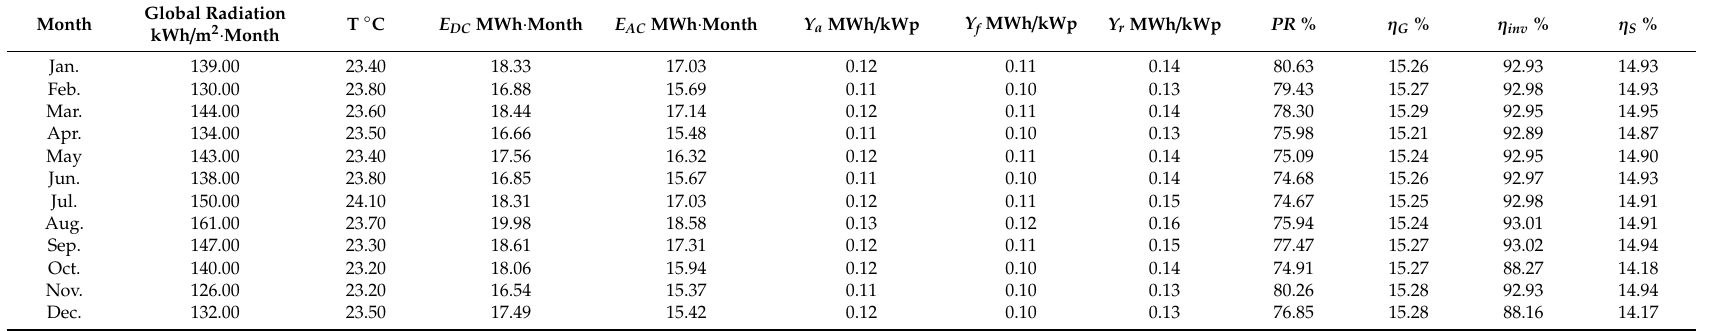
Table 5. Energy e ffi ciency analysis for Stage 1 of the PV system (152 kWp).